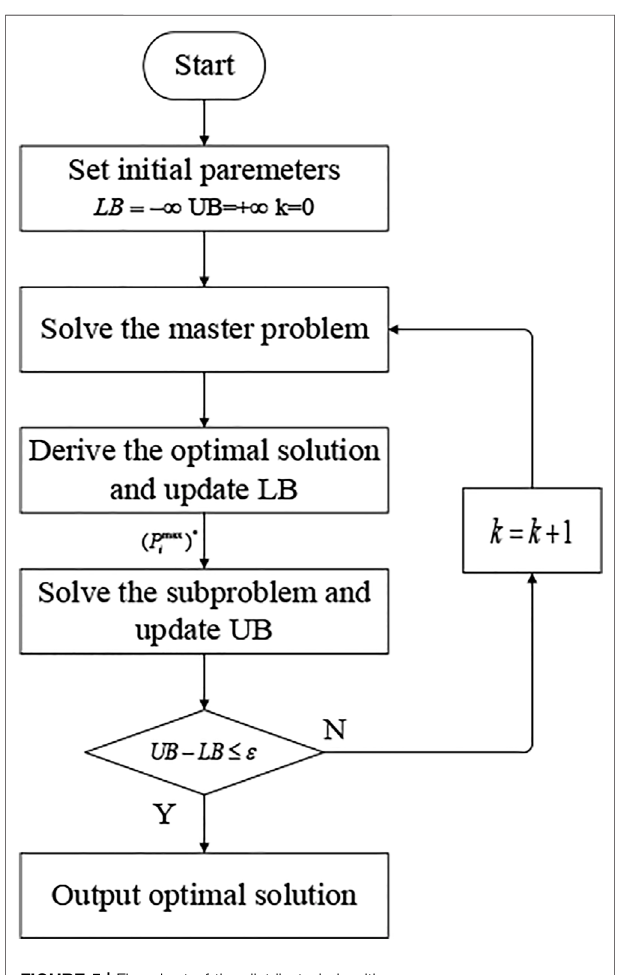
FIGURE 5 | Flowchart of the distributed